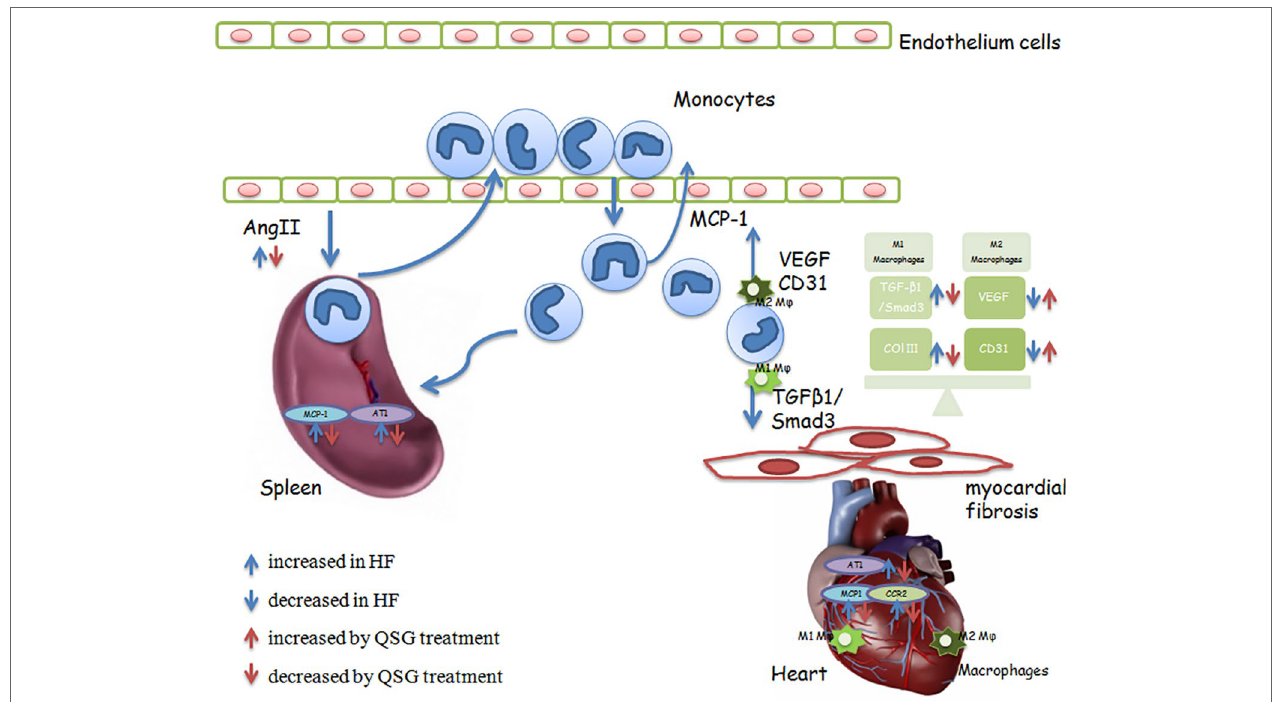
FIGURe 5 | QSG suppresses the release of spleen monocytes and recruitment to heart tissues through the splenic Ang II/AT1-cardiac MCP-1/CCR2 pathway to inhibit MR.